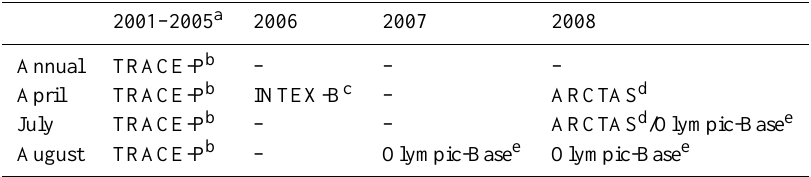
Table 1. Summary of the available STEM model runs and the applied anthropogenic emission inventories.